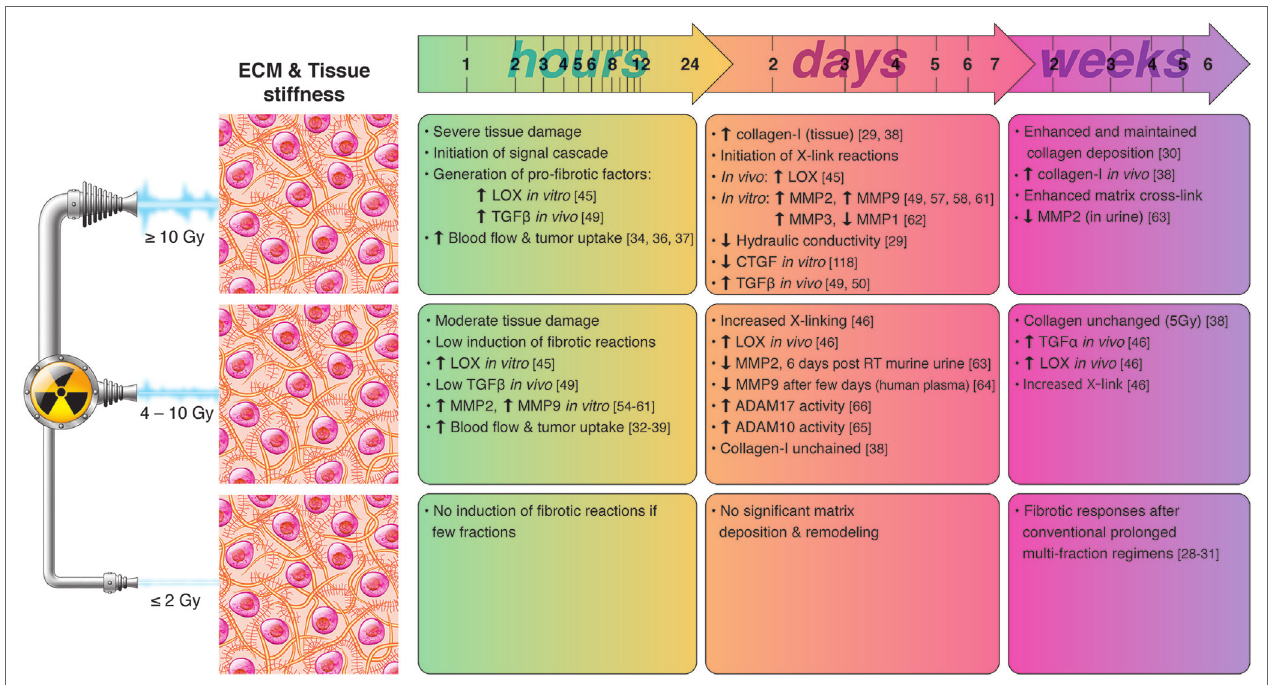
FiGURe 1 | Chronological effects observed on ECM remodeling agents and tissue stiffness after RT delivered at different dose per fraction. The figure is a compilation of observations registered in different experimental models, comprising primary cell cultures (in vitro), cell lines, animal (mainly mice) models, and clinical observations, on effects of RT given at different dose/fraction. Radiation schemes range from single fractions to oligo (daily) fractions and prolonged multifractionated regimens. The vast majority of preclinical observations comprise RT regimens of one or few fractions irrespective of the radiation dose. In clinical settings, RT protocols comprising moderate or high doses are always applied in one or few fractions . Although some inconsistencies may exist between studies, it is generally observed that small doses in few fractions do not ignite substantial changes in ECM composition and tissue stiffness, whereas both medium and high RT doses exert measurable changes on matrix deposition and tissue stiffness in a dose- and time-dependent manner. RT mediated pro-fibrotic effects and matrix stiffness may become apparent several days post-irradiation and may last for weeks and months after